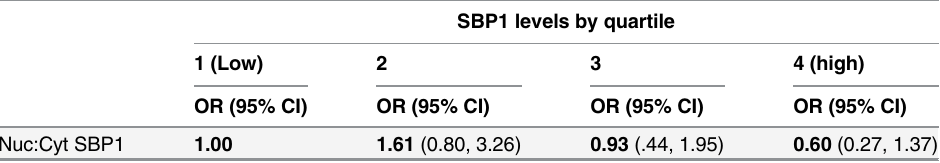
Odds ratios (OR) and 95% con fi dence intervals (CI) for prostate cancer recurrence by quartile of nuclear to cytoplasmic SBP1 expression. Expression level was measured by the VECTRA quantitative imaging system, and all OR estimates are adjusted for PSA, Gleason grade, tumor stage, and patient age at diagnosis.